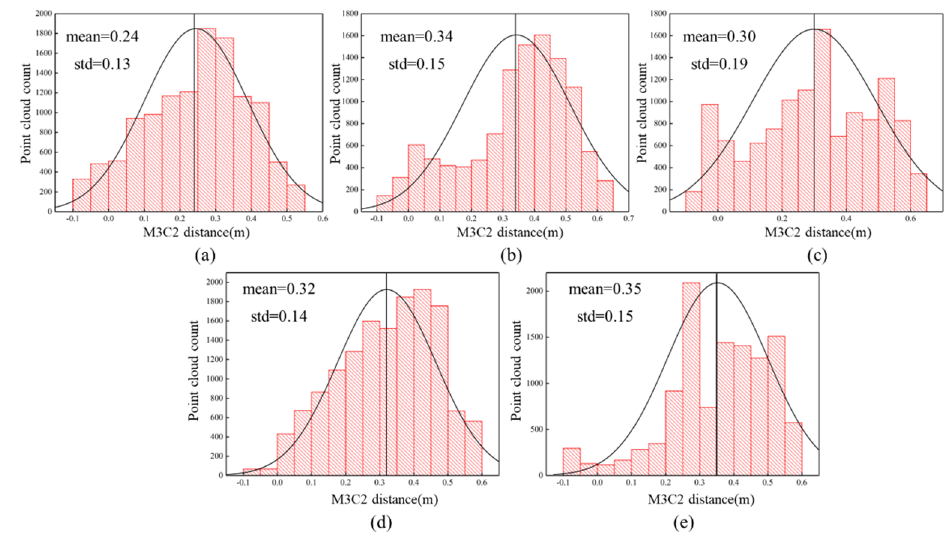
Figure 4. Histogram of the M3C2 distance: ( a ) LiDAR01.16 − UAV06.14; ( b ) LiDAR01.16 − UAV07.20; ( c ) LiDAR01.16 − UAV09.07; ( d ) LiDAR01.16 − UAV11.15; and ( e ) LiDAR01.16 − UAV07.31.